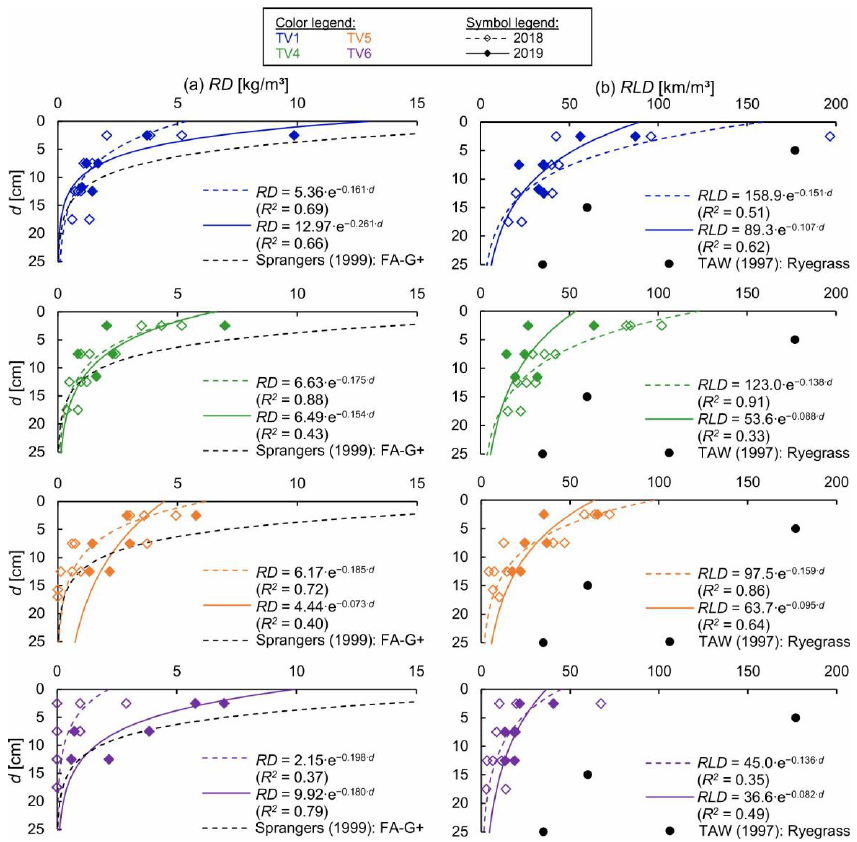
Figure 5. Root density RD ( a ) and root length density RLD ( b ) of different vegetated covers as function of the depth under surface d . TV1 = species-poor grass-dominated mixture, TV4 = grass-herb mixture, TV5 = species-rich herb-dominated EcoDike mixture, TV6 = species-rich herb-dominated ready-mix, and grid = geogrid reinforcement. Comparison of data with previous studies [24,49], where FA-G+ corresponds to a fertilized, periodically grazed ryegrass dike section in Friesland-Boonweg [49].